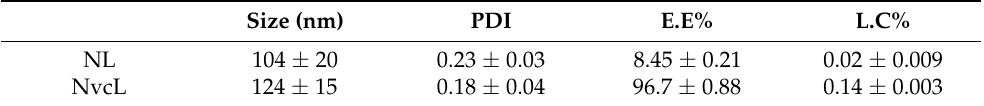
Table 2. Characterization of NL and NvcL formulations. Dynamic light scattering (DLS) measure- ments for size are represented by the mean hydrodynamic average diameter by intensity and the polydispersity index (PDI). This table also presents the encapsulation efficiency % and loading content % of siRNA encapsulated in NL and NvcL. The values and standard deviation are given for nine values, triplicates measured three times each ( n = 3).